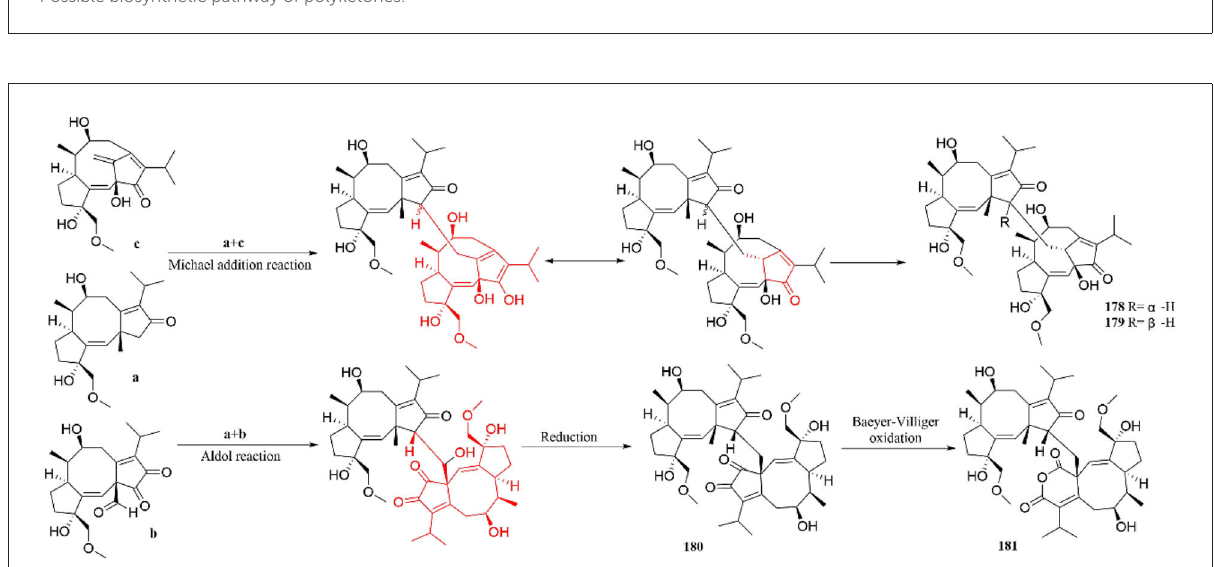
FIGURE15 Possible biosynthetic pathway of terpenoid